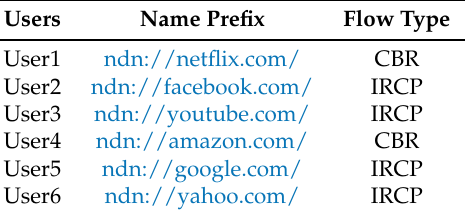
Table 1. Flow parameters for parking lot topology.